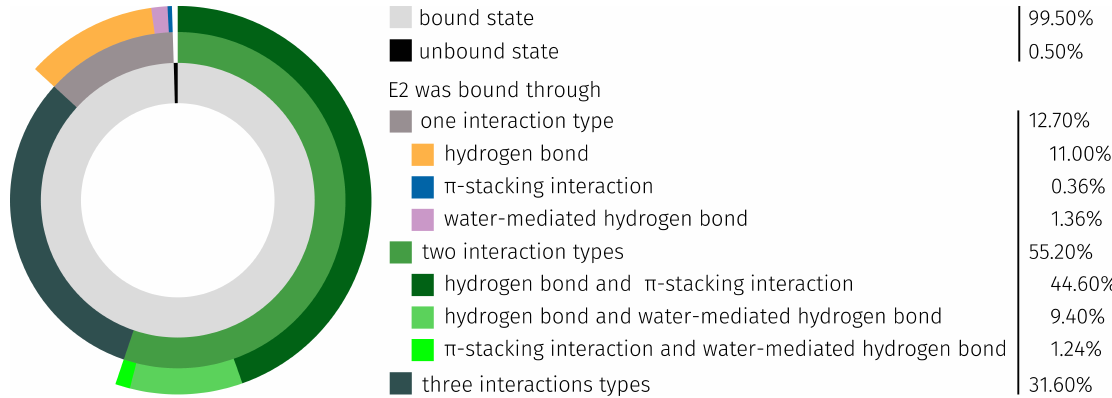
Figure 7. Donut chart of detected specific interactions between E2 and the E2-specific aptamer during the 25 ns MD simulation.